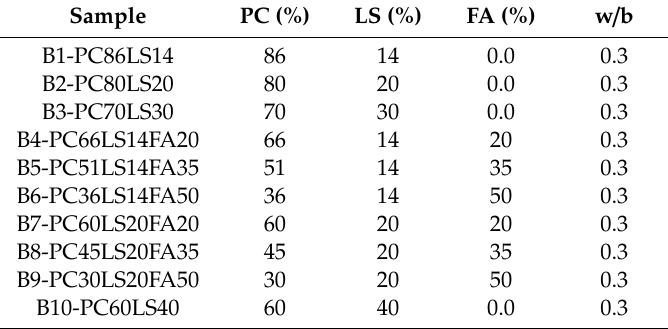
Table 1. Binary and ternary initial cement paste formulations—Mix Proportions % by total mass of binder. Sample PC (%) LS (%)